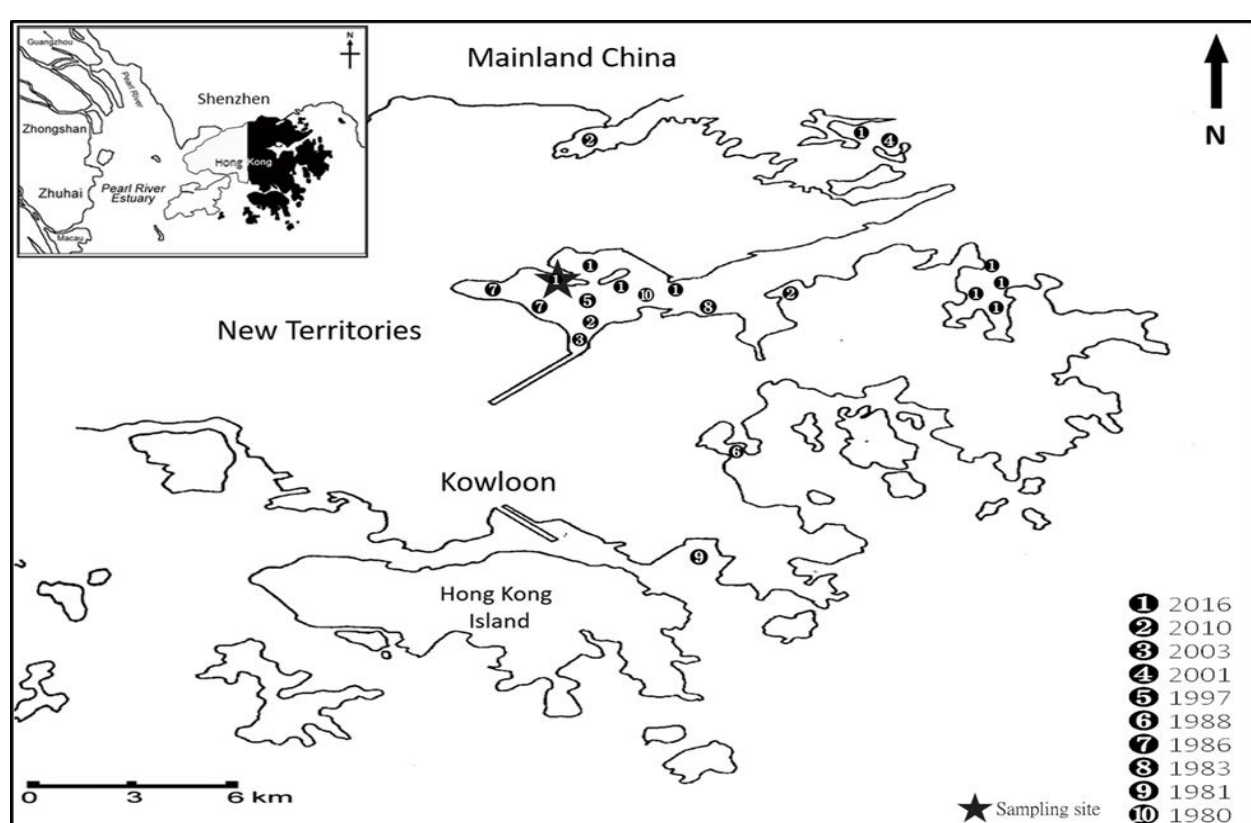
Figure A1. Occurrences and locations of Karenia mikimotoi blooms in Hong Kong waters between 1980 and 2016 (AFCD, 2021). The star ( (cid:70) ) indicates the sampling location, Yim Tin Tsai Fish Culture Zone.